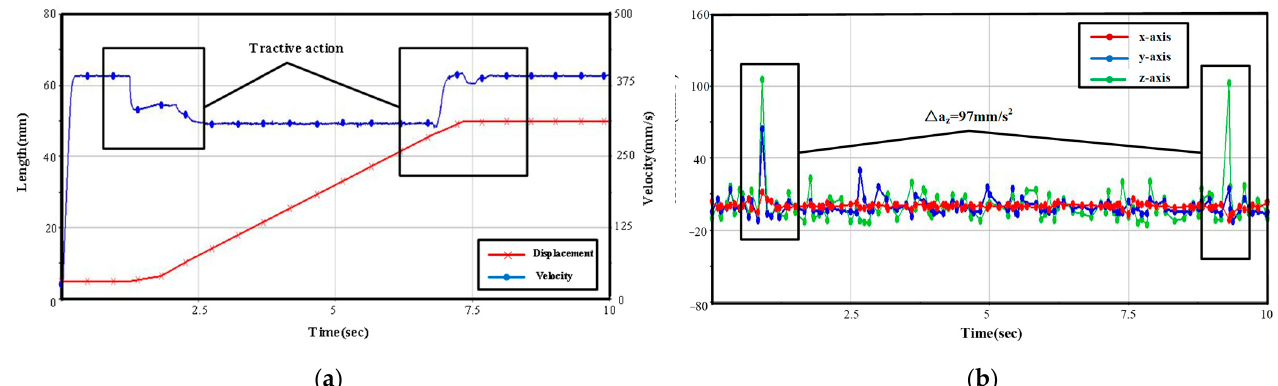
Figure 18. Simulation result diagram through slopes. ( a ) Robot centroid displacement and velocity; ( b ) robot centroid acceleration. ( b ) robot centroid acceleration.